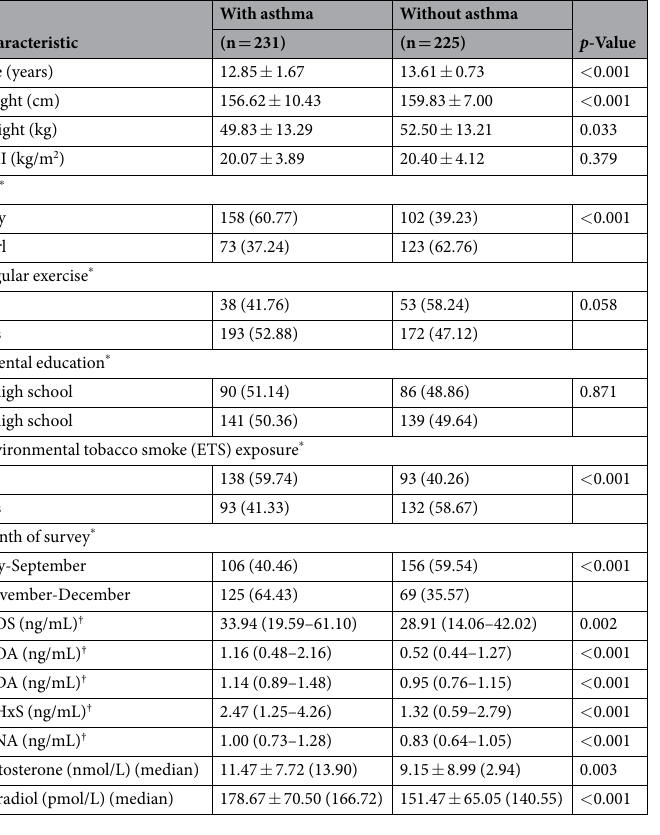
Table 1. Characteristics of the study population (n = 456). Values are mean ± SD. * Values are number (%). † Values are median